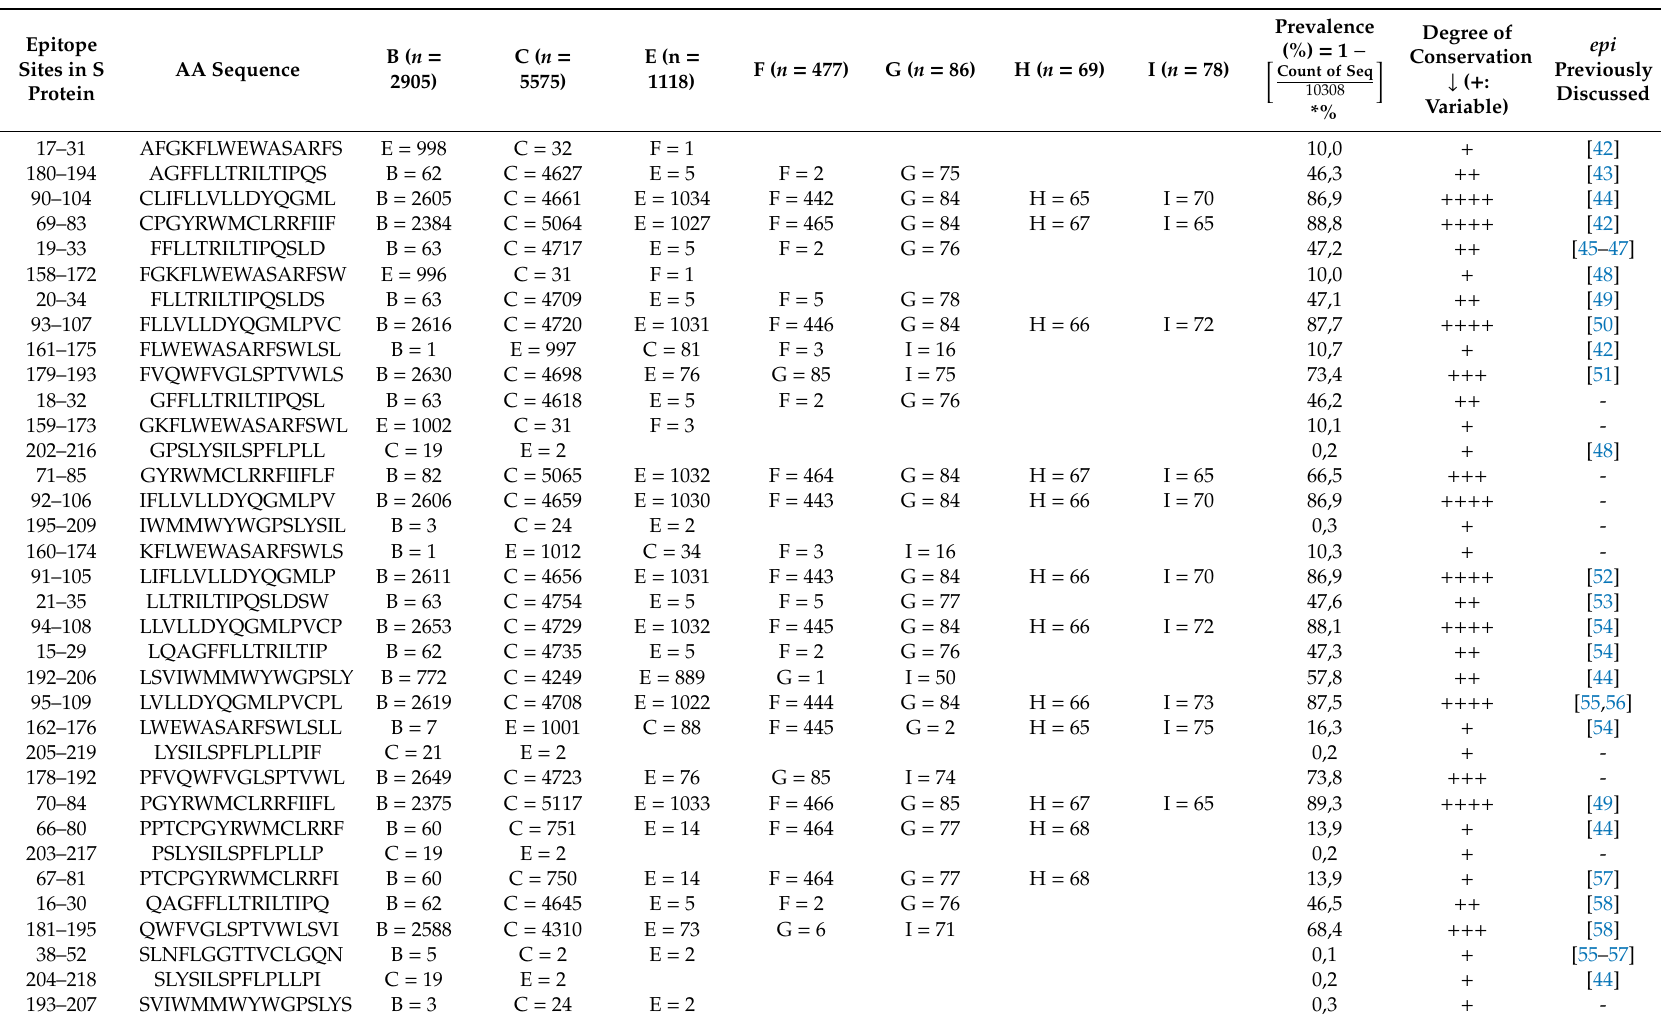
Table 2. Showing the prevalence of S protein epi in other HBV genotypes